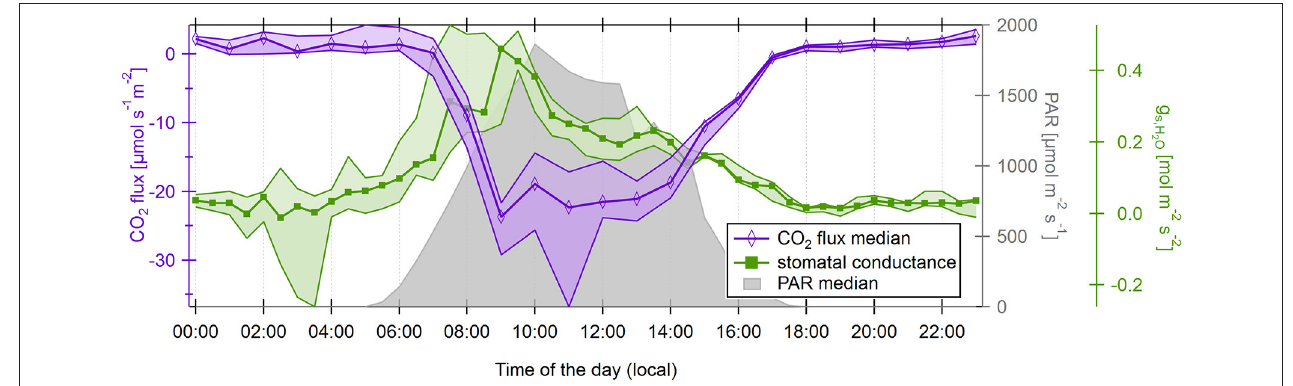
FIGURE 8 | Diel half-hourly medians and 25–75th percentiles (shaded areas) of canopy stomatal conductance at 26m (inside canopy), and of CO 2 flux at 41m height above ground level. The diel cycle of photosynthetic active radiation is displayed as gray